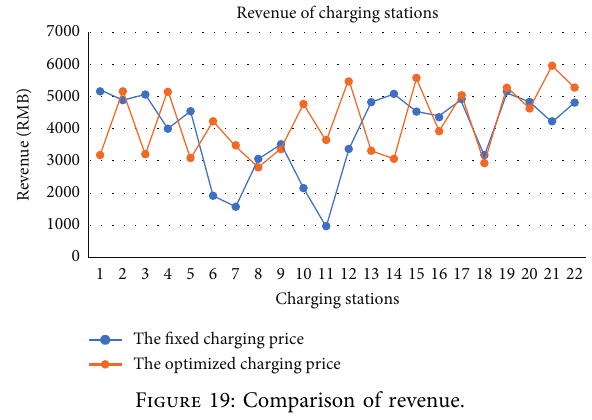
Figure 19: Comparison of